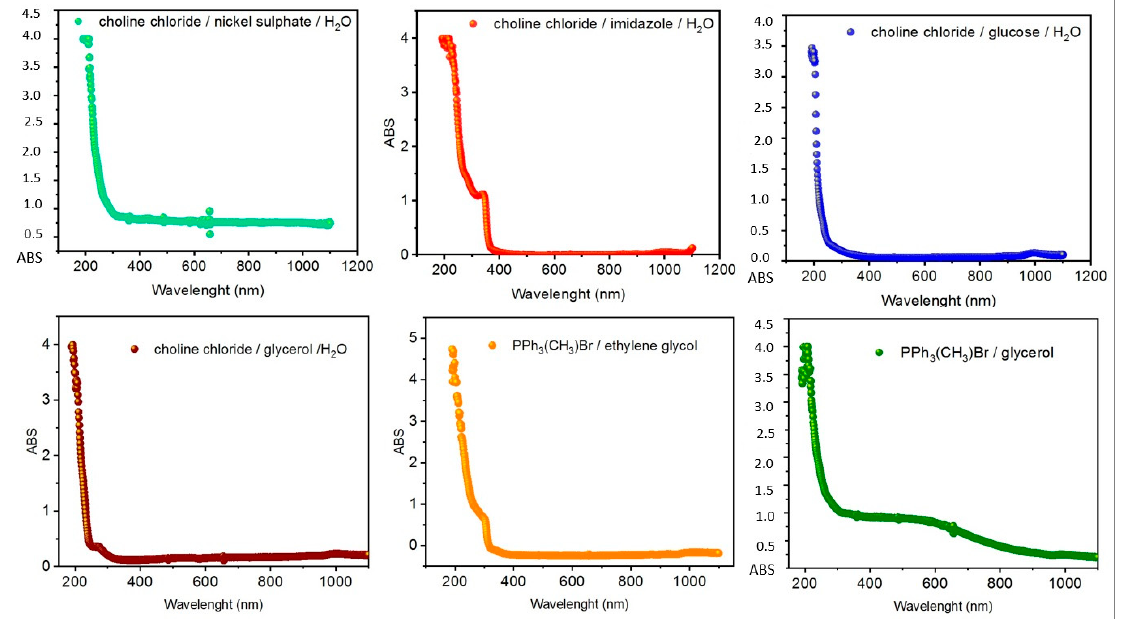
Figure 1. UV–VIS absorbance plots for (top-left) 1 , (top-center) 2 , (top-right) 3 , (bottom-left) 4 , (bottom-center) 5 , and (bottom-right) 6 .